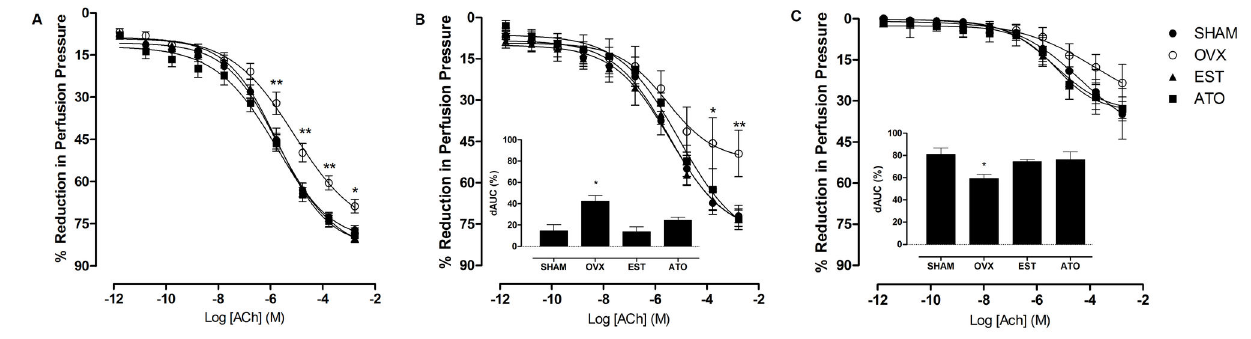
Figure 1. Effect of atorvastatin treatment on endothelium-dependent relaxation caused by acetylcholine in ovariectomized rats. The mesenteric vascular beds (MVBs) from control (SHAM), ovariectomized (OVX) and ovariectomized treated with 17β- estradiol (EST) or atorvastatin (ATO) groups were contracted with noradrenaline (NE) in the absence (A) or presence of aminoguanidine (B) or N G -nitro-L-arginine methyl ester (L-NAME) (C). The inset shows differences in the area under the concentration-response curves (dAUC%). The responses are expressed as the percentage of reduction in the perfusion pressure relative to the contractions induced by NE. Each point represents the mean of 6 experiments ± S.E.M. **P<0.01 and *P<0.05 vs. the SHAM group by two-way ANOVA followed by Tukey’s test. doi: